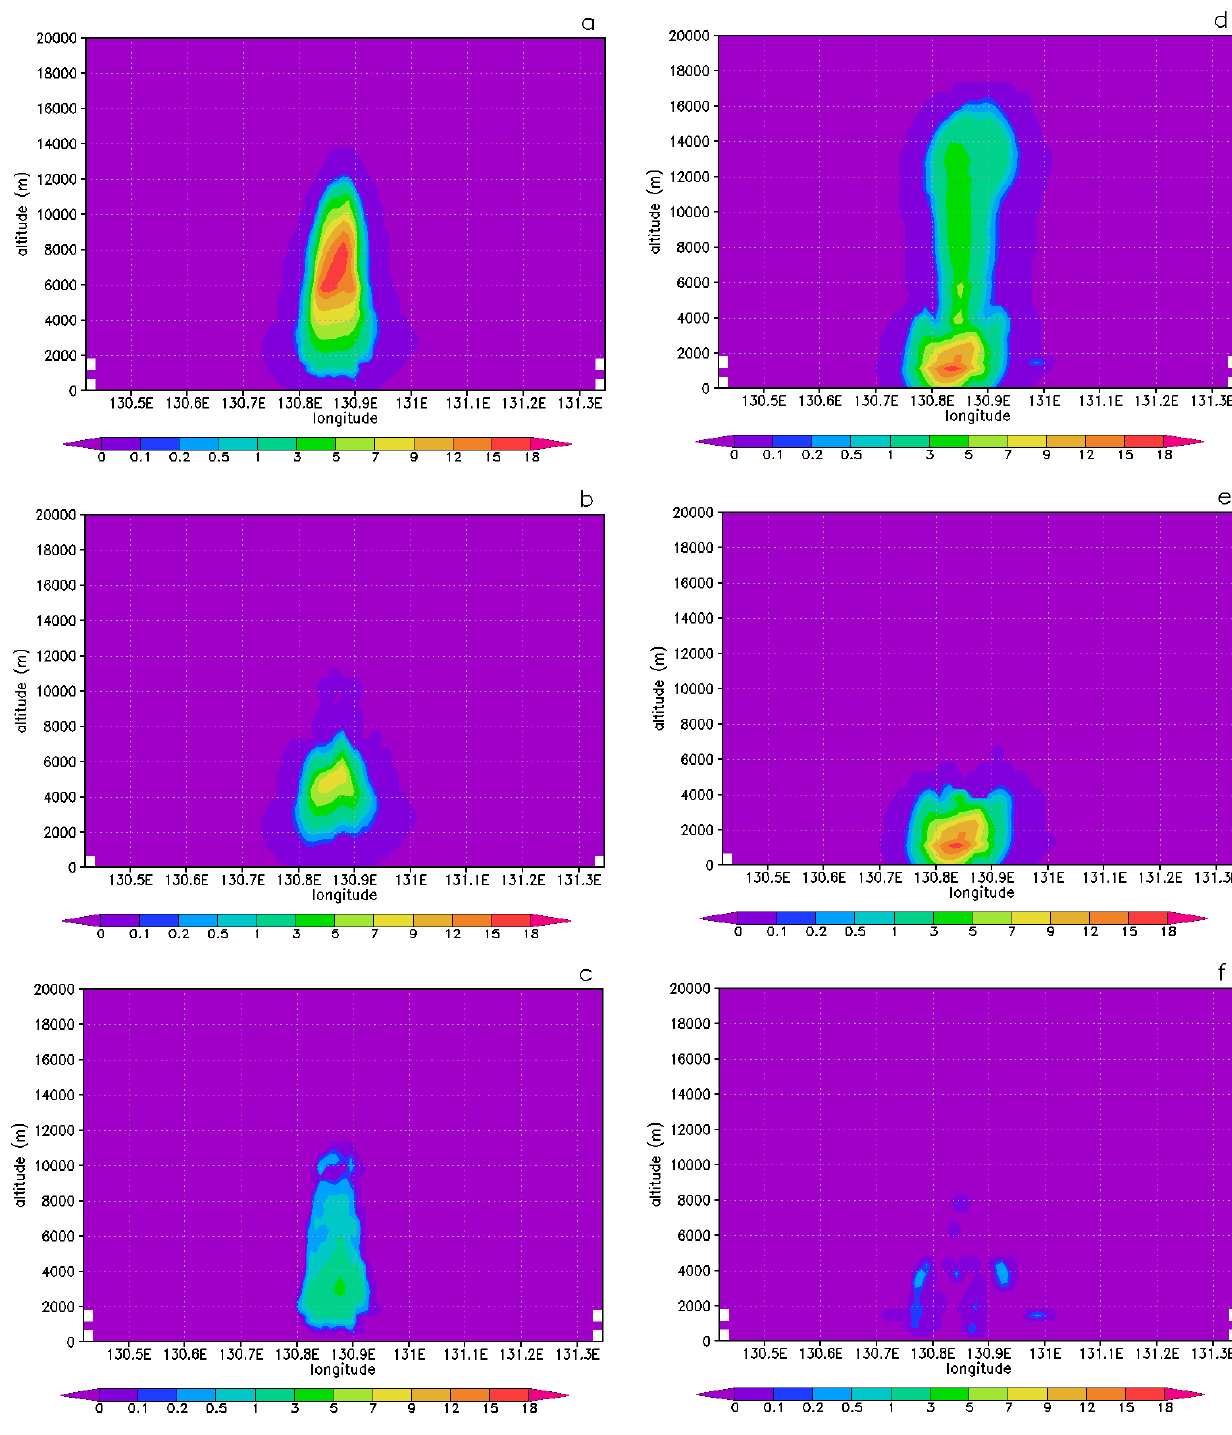
Fig. 5. Longitude-altitude cross section at 12.4 ◦ S of (a) the total condensed water (liquid+ice) mixing ratio (gkg − 1 ) at t 0 + 20min, (b) the Figure 5: Longitude-altitude cross section at 12.4° S of a) the total condensed water (liquid + ice) rain mixing ratio (gkg − 1 ) at t 0 + 20min, (c) the liquid cloud mixing ratio (gkg − 1 ) at t 0 + 20min, (d) the total condensed water (liquid+ice) mixing ratio (g.kg -1 ) at t +20 min, b) the rain mixing ratio (g.kg -1 ) at t +20min, c) the liquid mixing ratio at t 0 + 30min, (e) the rain mixing ratio (gkg − 1 ) at t 0 + 30min and (f) the liquid cloud mixing ratio at t 0 + 30min. t 0 is 5 days 0 0 and 6h after the beginning of the cloud mixing ratio (g.kg -1 ) at t +20 min, d) the total condensed water (liquid + ice) mixing ratio 0 at t +30min, e) the rain mixing ratio (g.kg -1 ) at t +30min and f) the liquid cloud mixing ratio at 0 0 t +30min. t is 5 days and 6 hours after the beginning of the simulation. 0 0